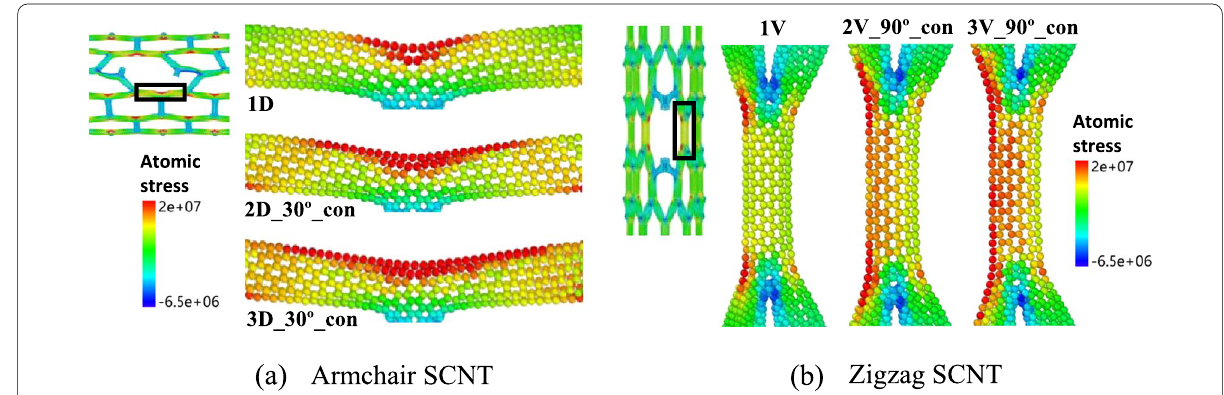
Fig. 6 Local atomic stress distributions of the defective SCNTs. a Different defective armchair SCNTs under the same strain of 0.251; b Different defective zigzag SCNTs under the same strain of